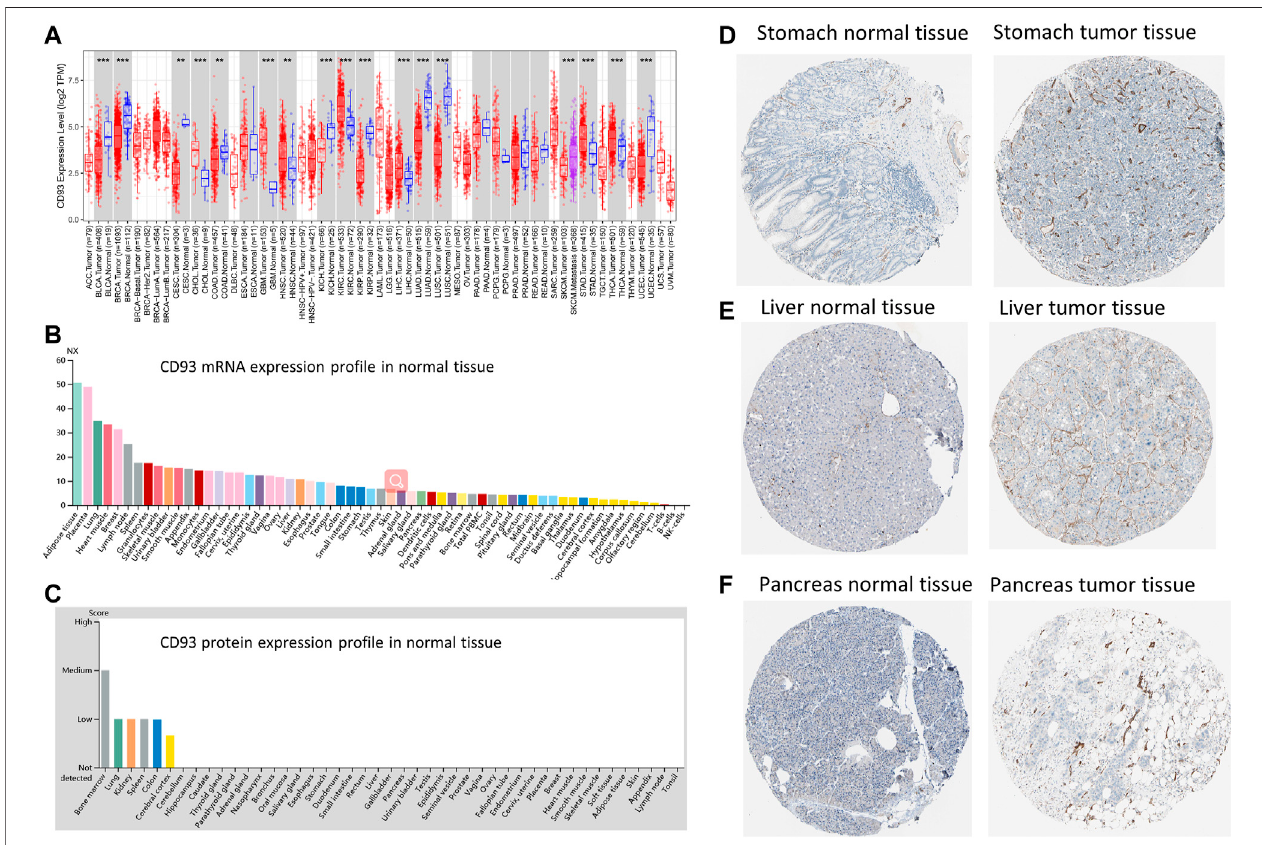
FIGURE 1 | Gene and protein expression pro fi les of CD93 in tumor and normal tissues. (A) Differential expression of CD93 between normal and tumor tissues based on the Tumor Immune Estimation Resource (TIMER2.0) database. Red , blue , and magenta represent tumor, normal, and metastasis tissues, respectively. (B) CD93 mRNA expression overview in normal human tissues. (C) CD93 protein expression overview in human normal tissues. (D – F) Representative immunohistochemistry (IHC) images of CD93 proteins in normal and tumor tissues of the breast, liver, and pancreas.